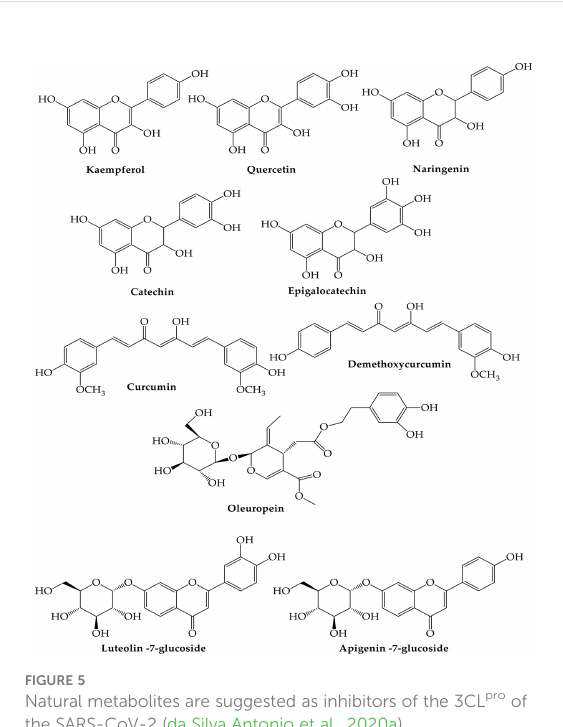
FIGURE 5 Natural metabolites are suggested as inhibitors of the 3CL pro of the SARS-CoV-2 (da Silva Antonio et al.,